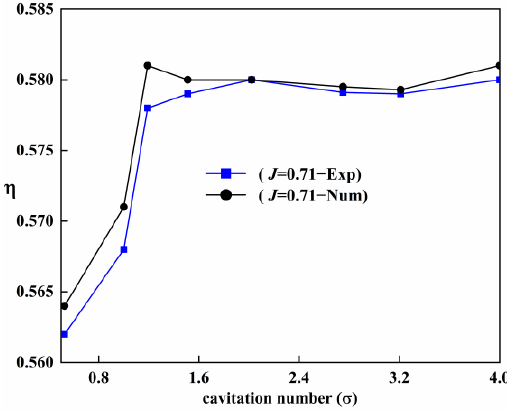
Figure 9. Comparison of CFD values with experimental values at different cavitation numbers.